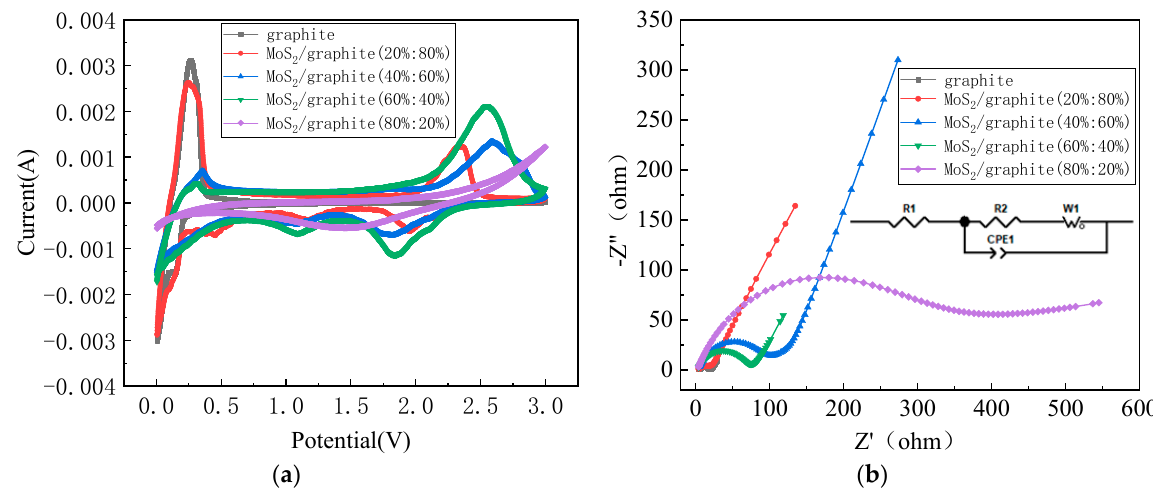
Figure 6. ( a ) CV test curves; ( b ) EIS test curves.